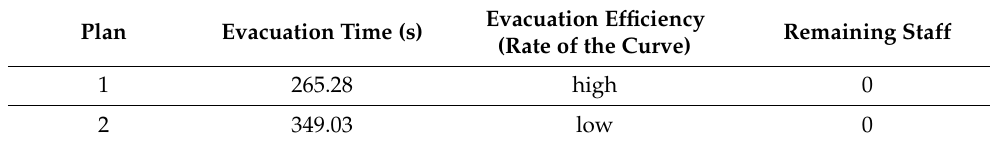
Table 3. Data comparison between two plans.